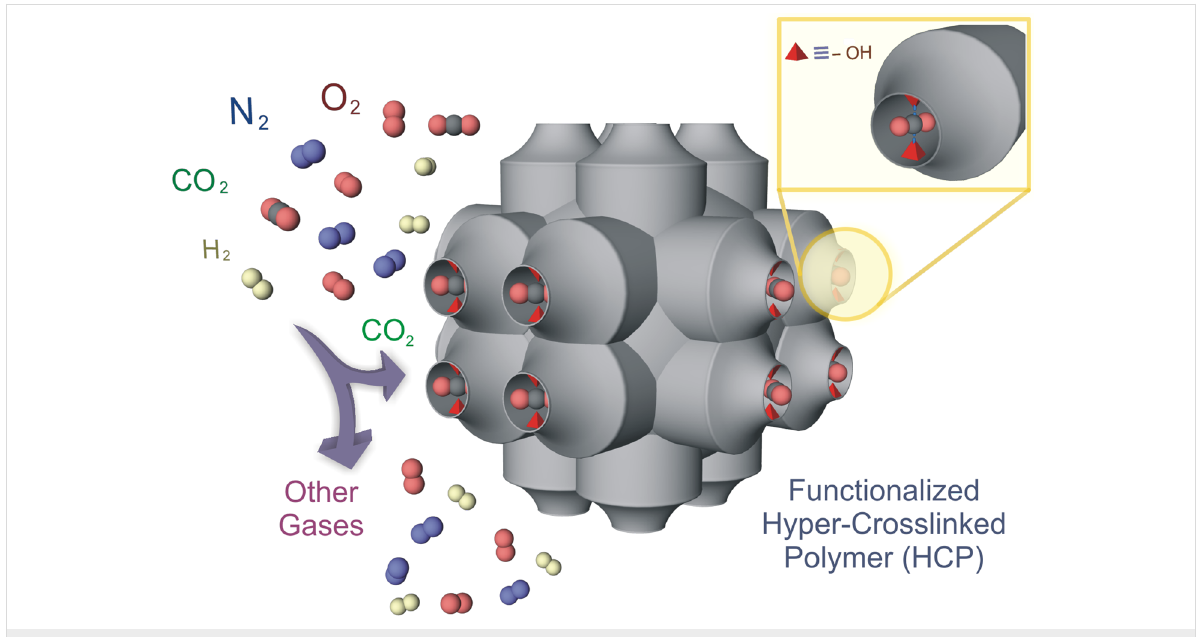
Scheme 1: Schematic representation of selective CO 2 capture in a porous